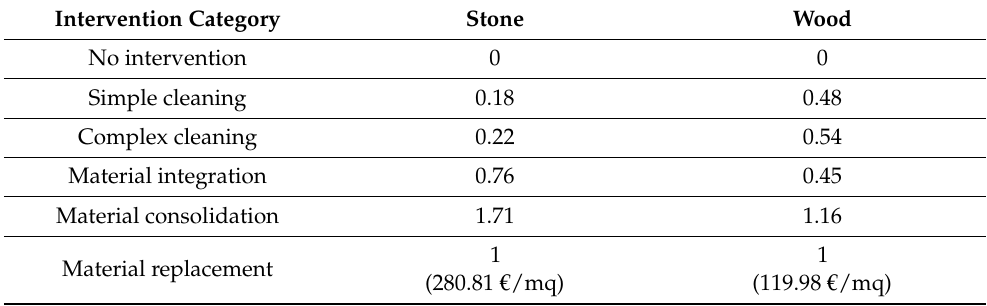
Table 4. Kc values. Table 4. Kc